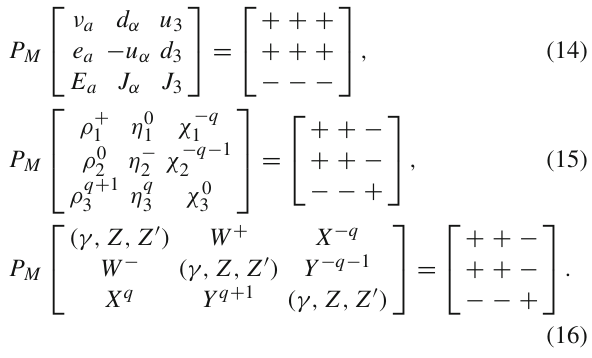
Table 1 A roadmap for 3-3-1 versions and relevant vacuum structures. Minimal: The minimal 3-3-1 model and its variants for β = q = 1); RHNs: The 3-3-1 model with right-handed neutrinos and its √ variantsfor β = − 1 / 3(or q =